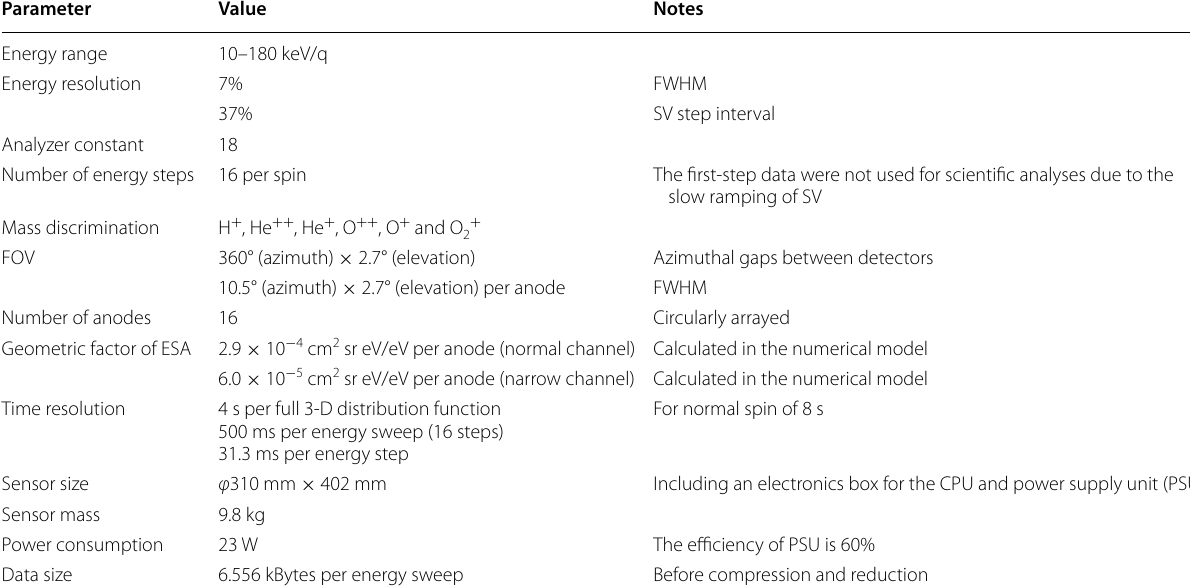
The resolution is indicated by the full-width at half maximum